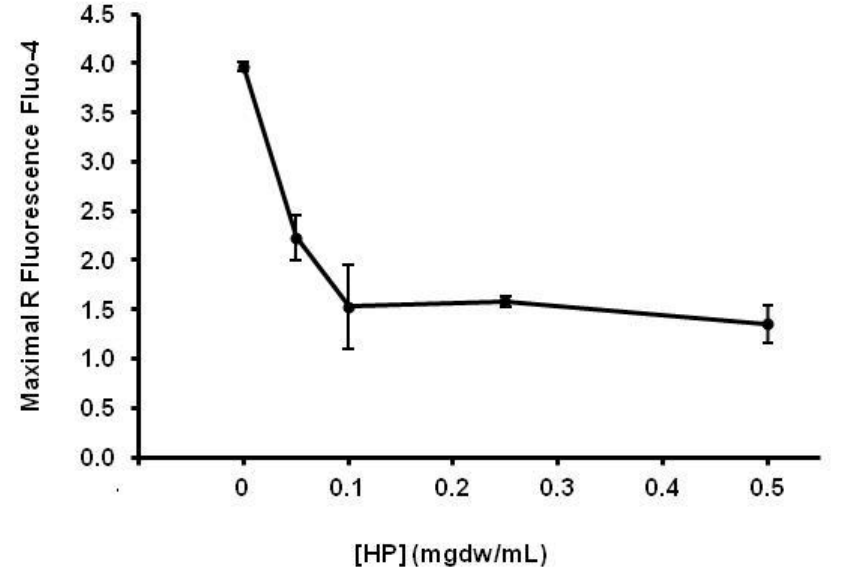
Figure 2. Effect of HP on maximal free cytosolic Ca++ response after stimulation of whole blood platelets with thrombin 0.05 U/mL). Fluorescence ratios = mean FL1 intensity in agonist-stimulated platelets/mean FL1 intensity in unstimulated platelets. Data are presented as mean +/ − SEM for three different experiments with the same donor.